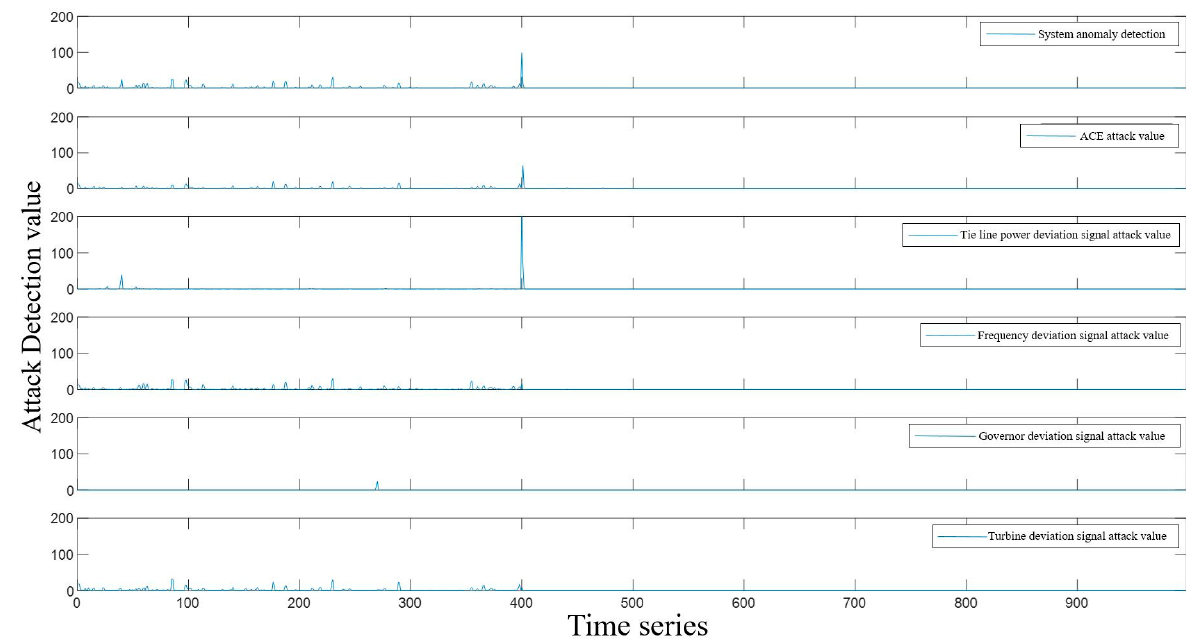
Figure 9. Quantitative Detection of Double-State Variable False Data Injection Attack.